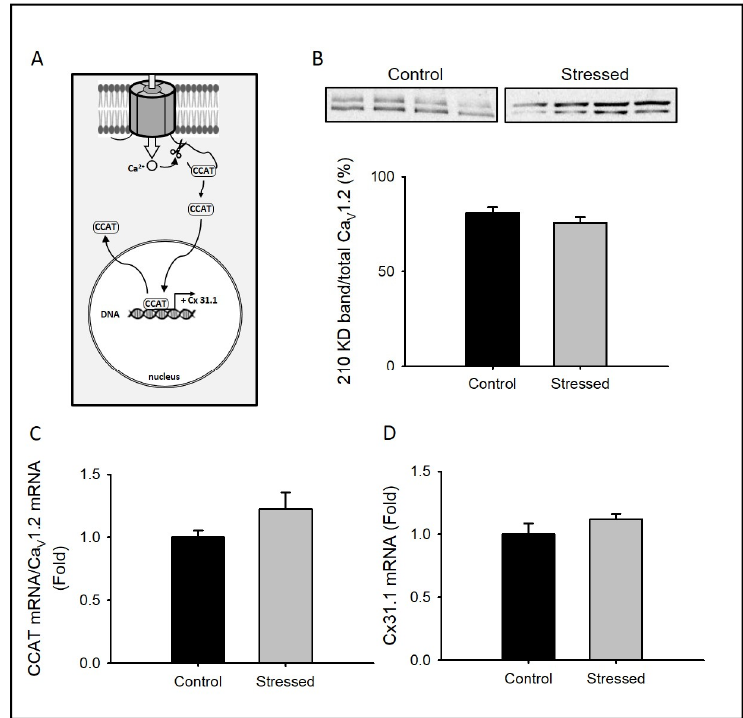
Figure 5. Calcium channel associated transcriptional regulator (CCAT)-dependent signaling in CRS-subjected animals: ( A ) Schematic diagram depicting the signaling pathway studied in this figure ( B ) Bar graph of 210 kD Ca v 1.2 protein expression normalized to total Ca v 1.2 protein expression (210 kD + 240 kD) from whole hippocampus lysates ( n = 8), in the upper part, a representative immunoblot showing Ca v 1.2 protein expression is shown. Bar graph of semi-quantitative PCR expression for the CCAT mRNA normalized to the Ca v 1.2 mRNA ( C ) or Cx31.1 mRNA ( D ) isolated from whole hippocampus of juvenile rat controls ( n = 8) or subjected to CRS for 3 weeks ( n = 8). Bar graphs are mean ± SEM; black bars are control animals, and gray bars correspond to CRS-subjected animals.